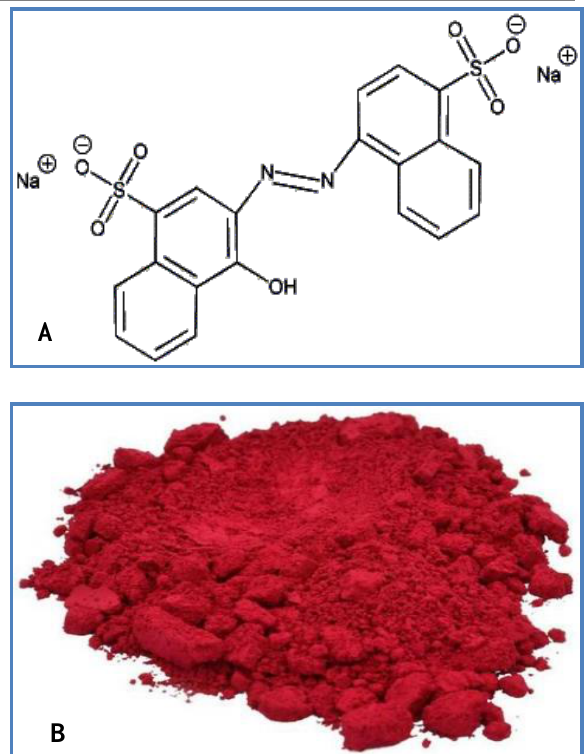
Figure, 1A and B: Chemical structure (A) and powder (B) of Azorubine (3 and